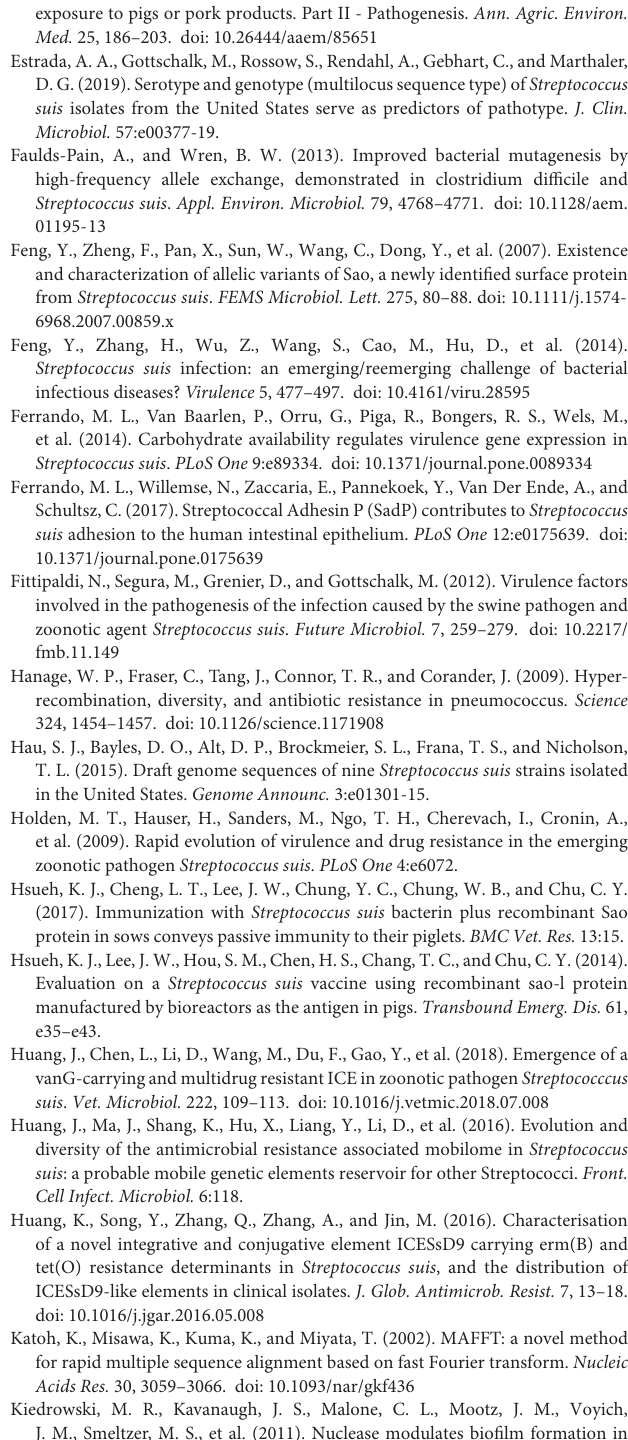
Supplementary Figure 2 | Comparison of capsule loci. Colored arrows represent the genes present within the CPS locus of the representative serotypes and S. suis isolates (left). Predicted function is indicated by the arrow color, as shown at the bottom. ISU2614 was chosen as a representative of the serotype 2 strains,